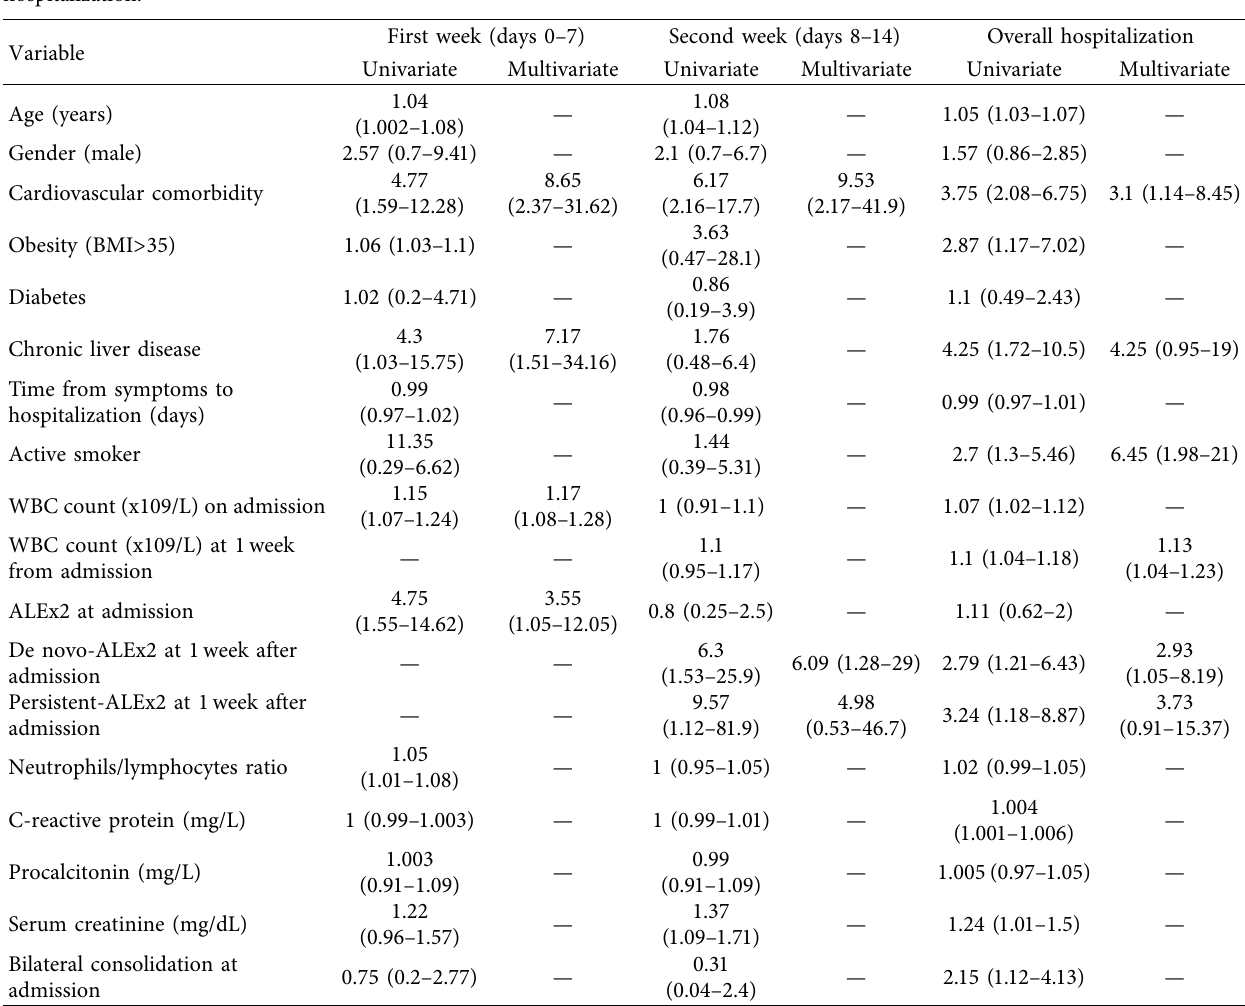
Table 4: Multivariate logistic regression evaluating risk factors for death associated with COVID-19 during different periods of